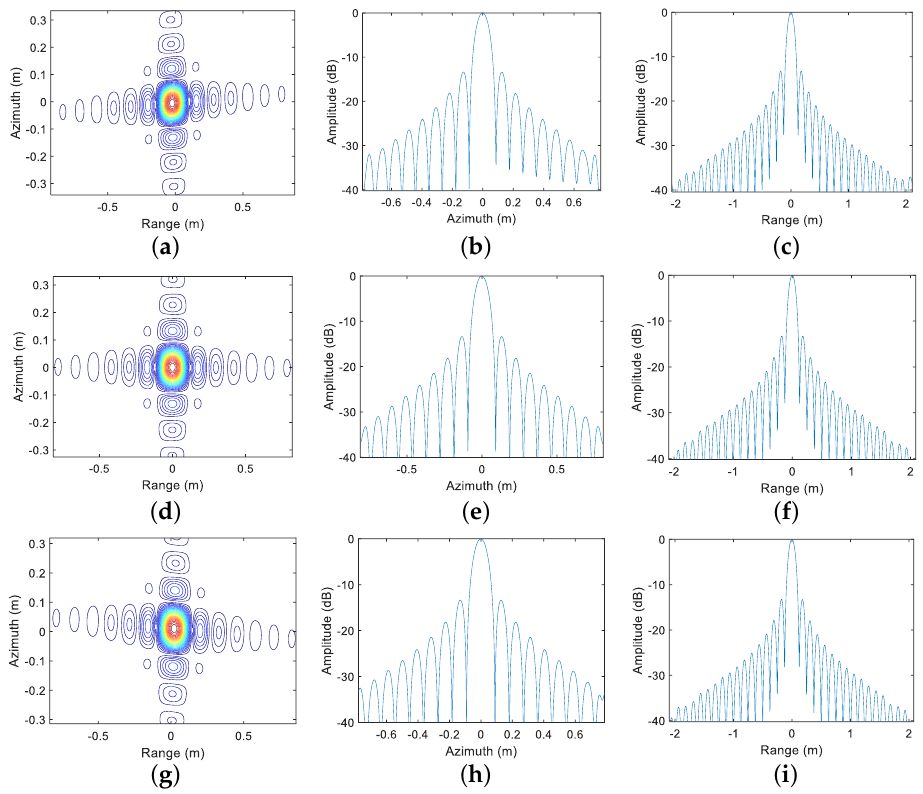
Figure 11. Contour plots (first column), azimuth (second column) and range profiles (third column) of the impulse response function for the three point targets P1 ( a – c ), P5 ( d – f ) and P9 ( g – i